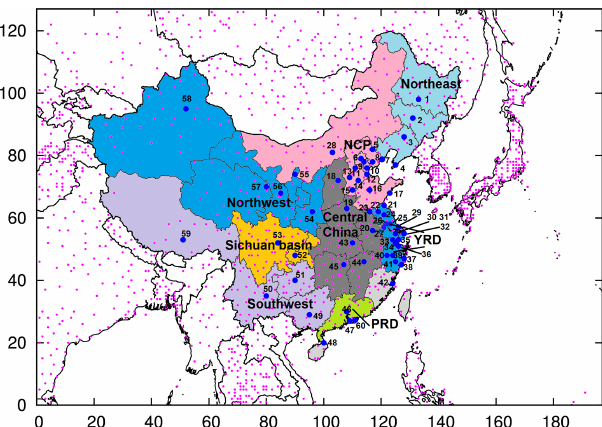
Figure 1. Model domain. The axes are the number of grid cells. Blue filled circles show the locations of cities with air quality ob- servations (see Table 2). The purple dots show the locations of me- teorological stations. The figure also shows the regions discussed in the text for better understanding. NCP represents North China Plain, YRD represents Yangtze River Delta, and PRD represents Pearl River